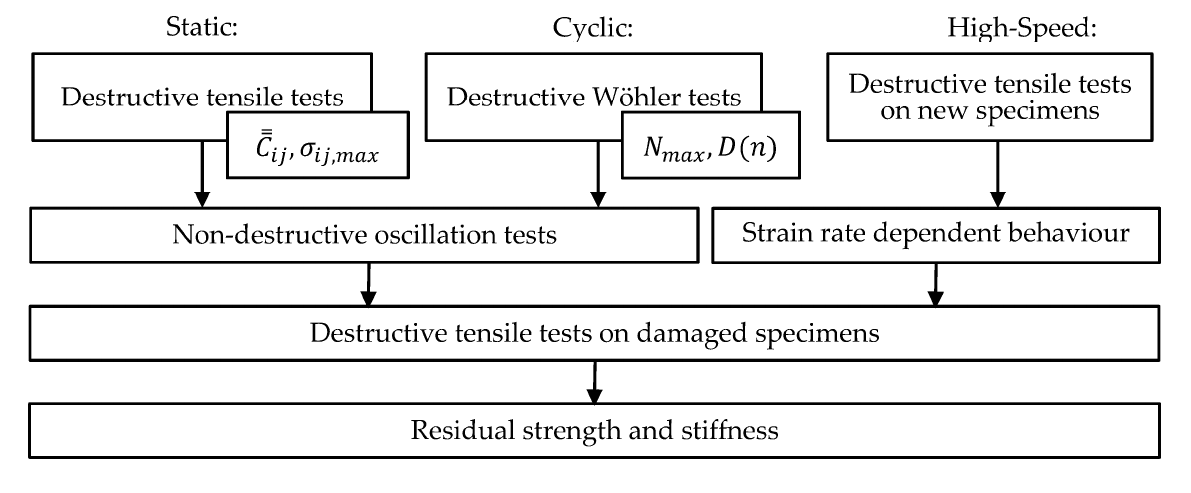
Figure 3. Schematic experiment workflow for material characterization.